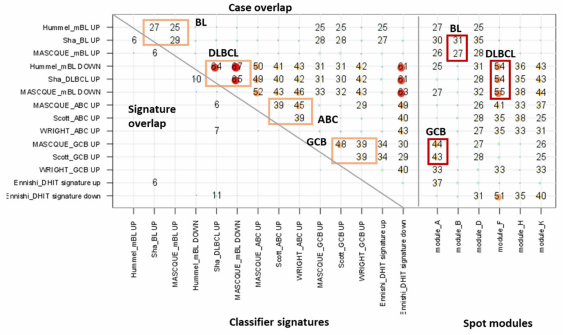
Figure A7. Signature gene intersection (left, lower triangle) and % jointly activated samples (GSZ >0, right, upper triangle). Only classifiers designed for the same subtypes are compared.